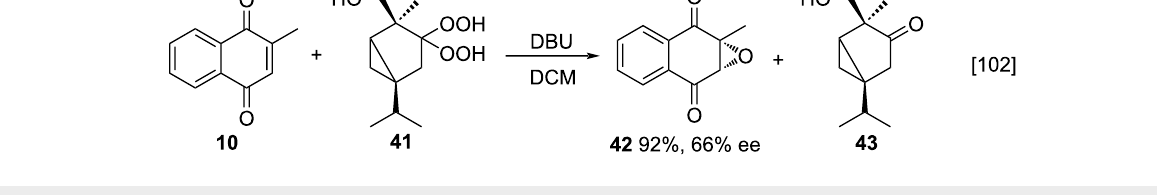
Scheme 11: DBU-catalyzed epoxidation of menadione ( 10 ).